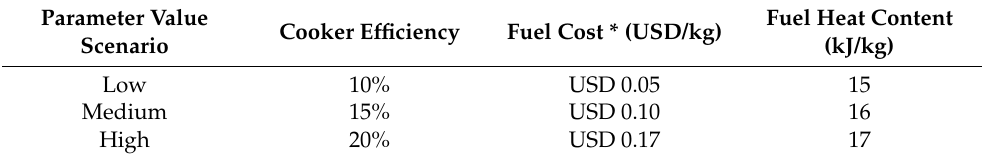
Table 4. WC MLCOE input parameters for calculation of the cost distribution in the WC medium-cost case. Parameter Value